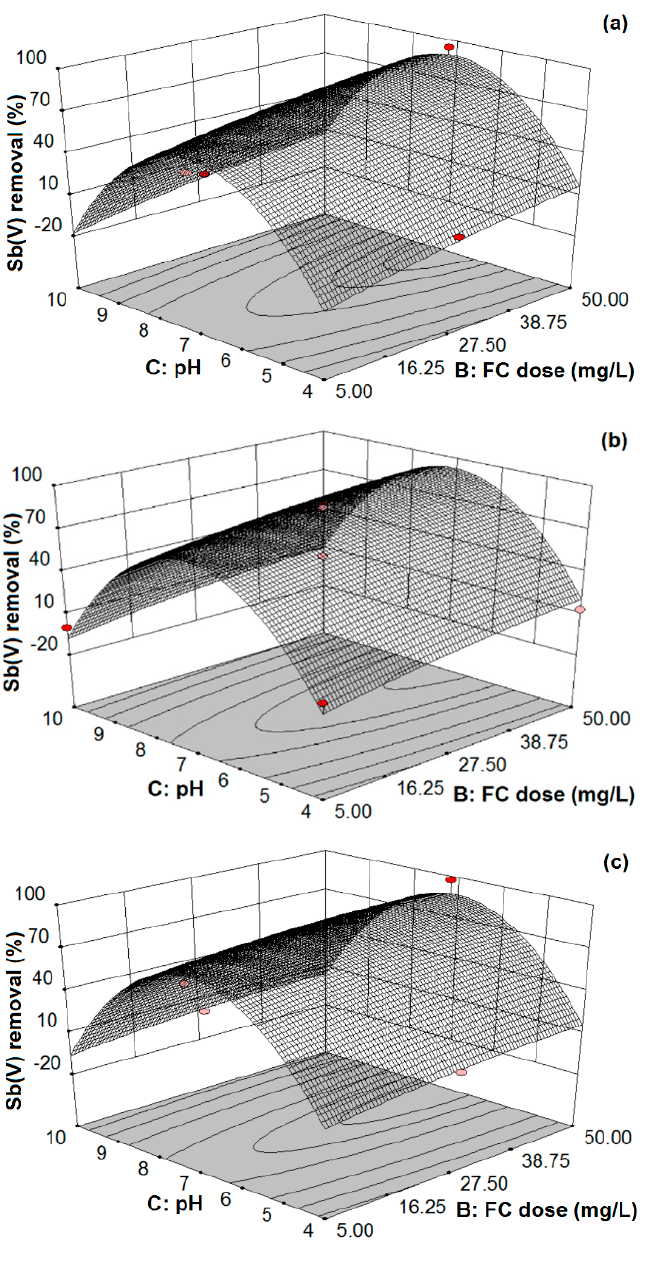
Figure 2. Three-dimensional surface plots and corresponding contour plots showing Sb(V) removal under various pHs (4–10) and FC doses (5–50 mg/L) for an Sb(V) concentration of ( a , d ) 100 µg/L; ( b , e ) 550 µg/L; ( c , f ) 1000 µg/L.